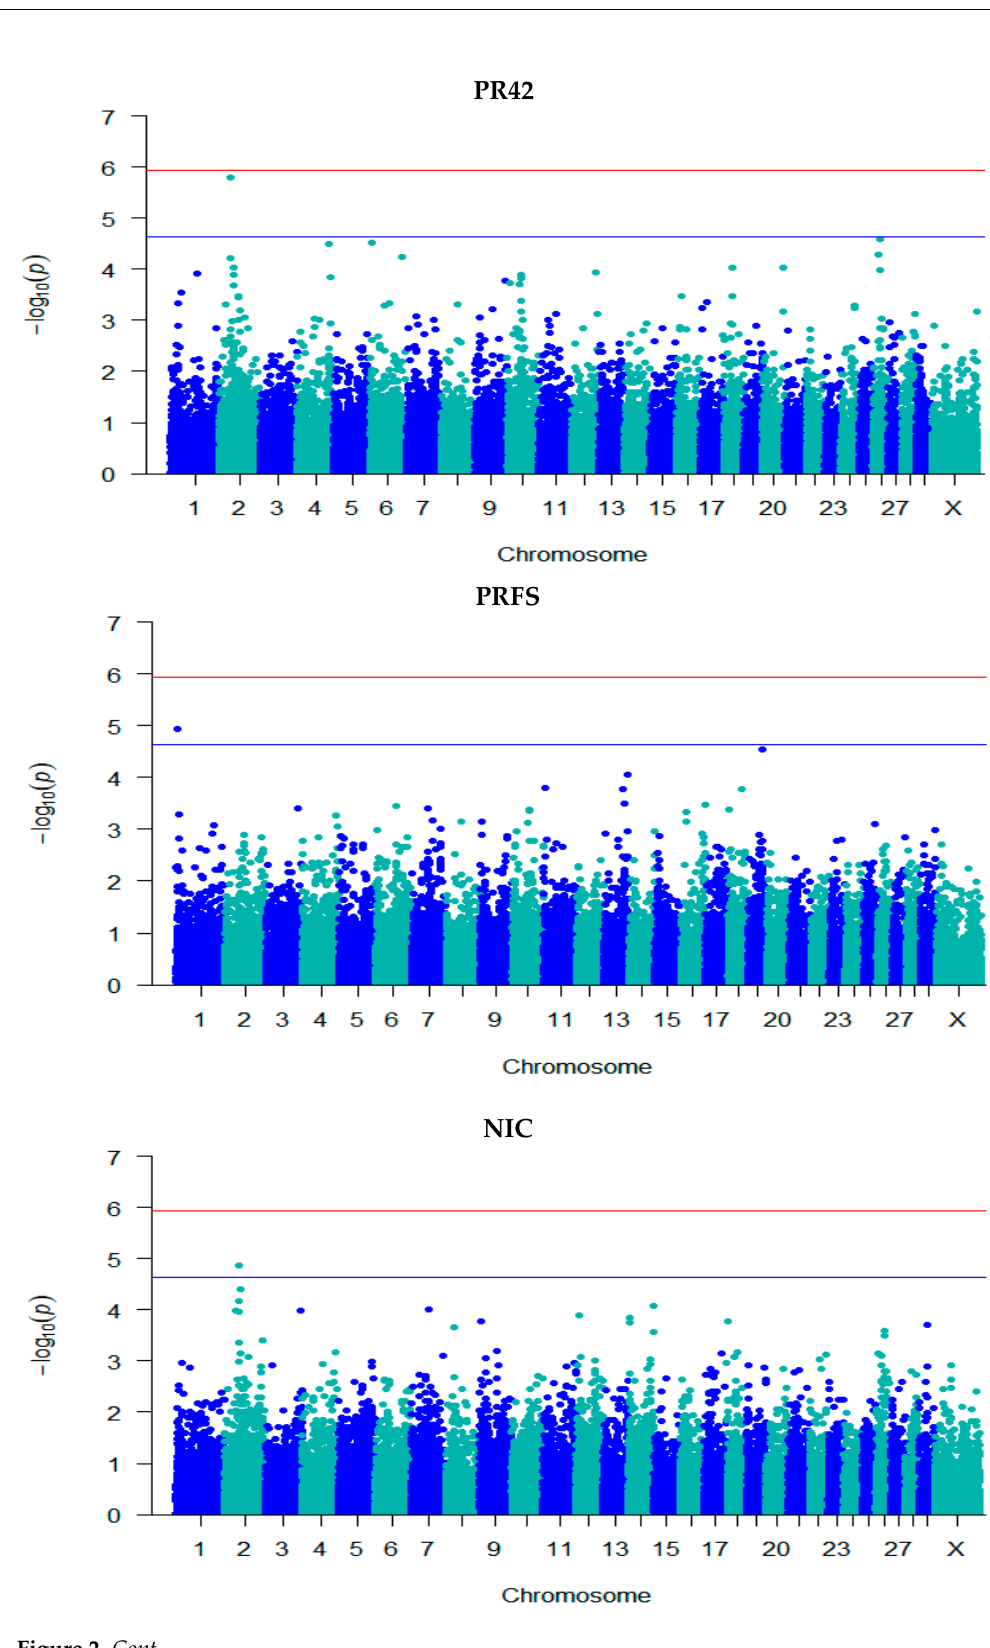
CR21 Figure 2. Cont